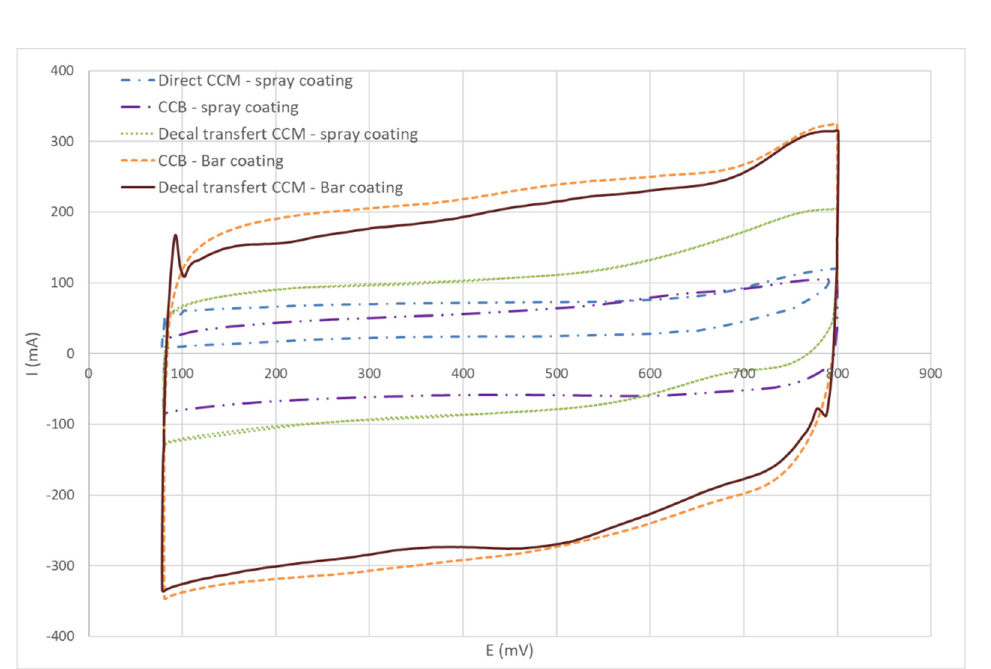
Figure 2. Cyclic voltammetry under H 2 /N 2 ; 80 °C; 100% RH and 1.5 bara pressure (CV made on Figure 3. Cyclic voltammetry under H 2 /N 2 ; 80 ◦ C; 100% RH and 1.5 bara pressure (CV made on MEA-1 in Table MEA-1 in Table 1). Table 1. EAS and Uf calculated for each printing technique used, with c = 0.2 F·m − 2 and S BET = 520 ± 20 m 2 /g Coating Technique